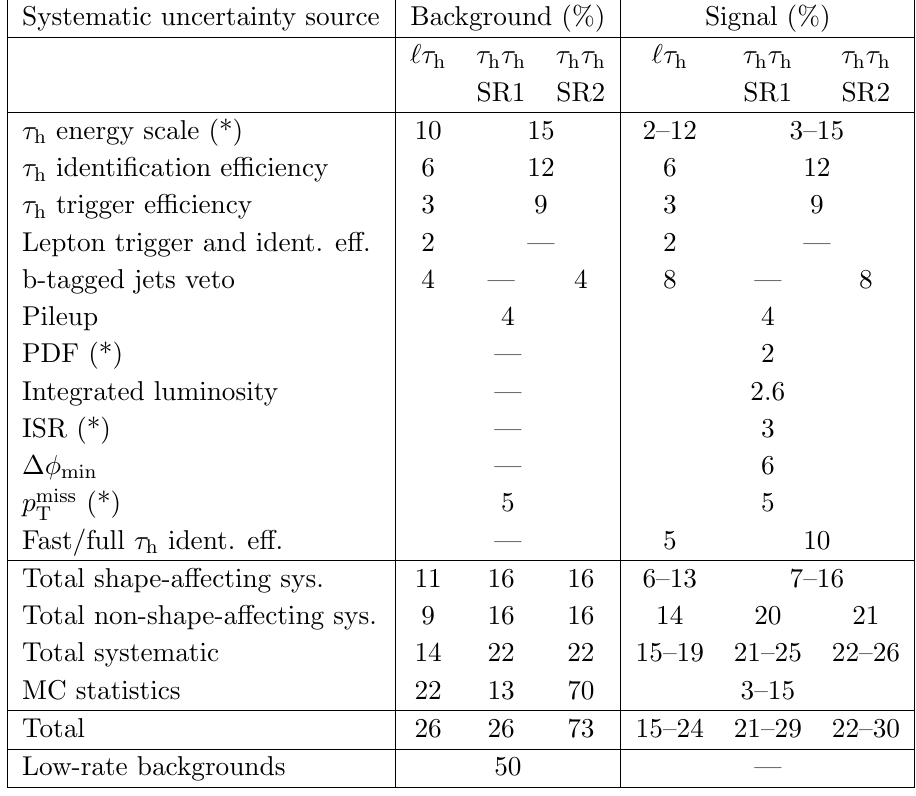
Table 6 . Summary of the systematic uncertainties that a(cid:11)ect the signal event selection e(cid:14)ciency, DY and rare backgrounds normalization and their shapes. The sources that a(cid:11)ect the shape are indicated by (*) next to their names. These sources are considered correlated between two signal regions of the (cid:28) h (cid:28) h analysis in the (cid:12)nal statistical combination. are expected. The dominant background source is W+jets events. As a cross-check, data and the prediction in the sideband (200 < (cid:6) M (cid:28) i < 250 GeV) are studied: 13 events T